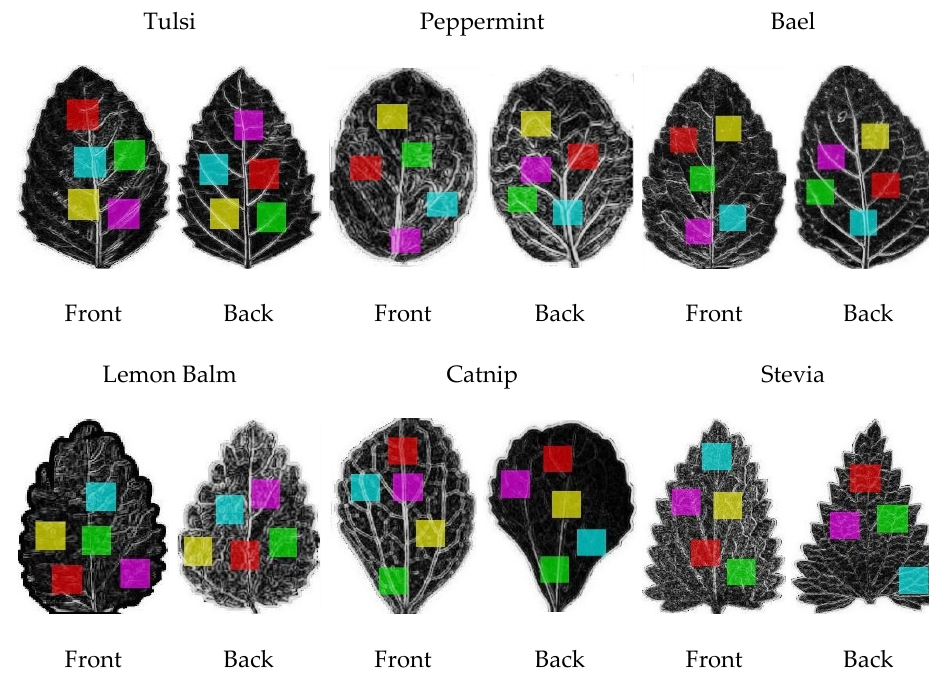
Figure 4. Sample of transformation into gray level and draw 5 colorful regions of observation on medicinal plant leaves dataset. medicinal plant leaves